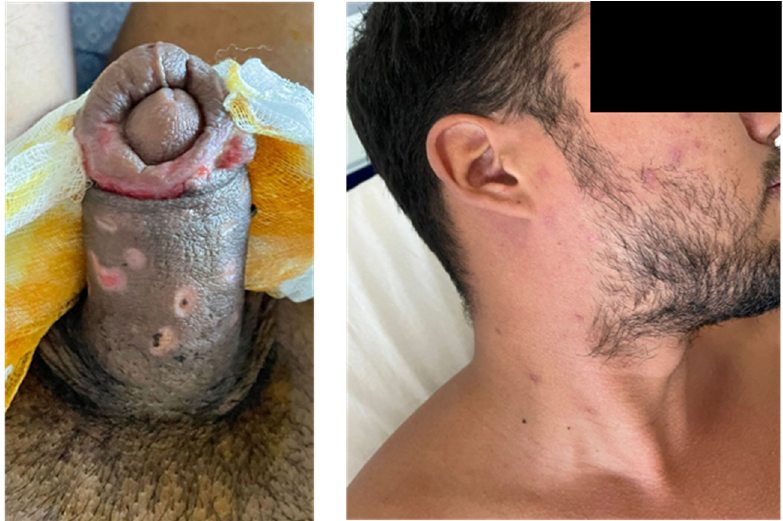
Figure 4. Changes in lesions 9 days following admission. On the left, the penis after surgical intervention: test for MPXV performed on the swab obtained by scraping this area, resulted still positive. On the right, facial lesions on the mend.